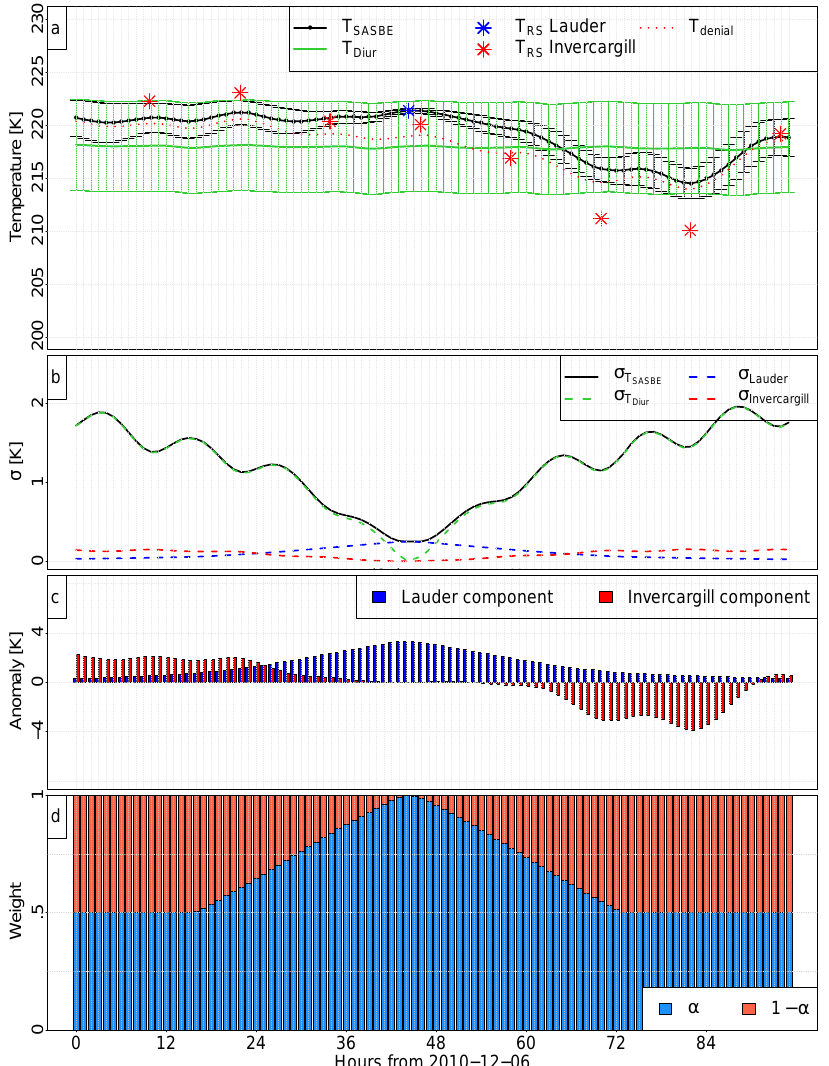
Figure 5. As in Fig. 4, but at 150hPa.